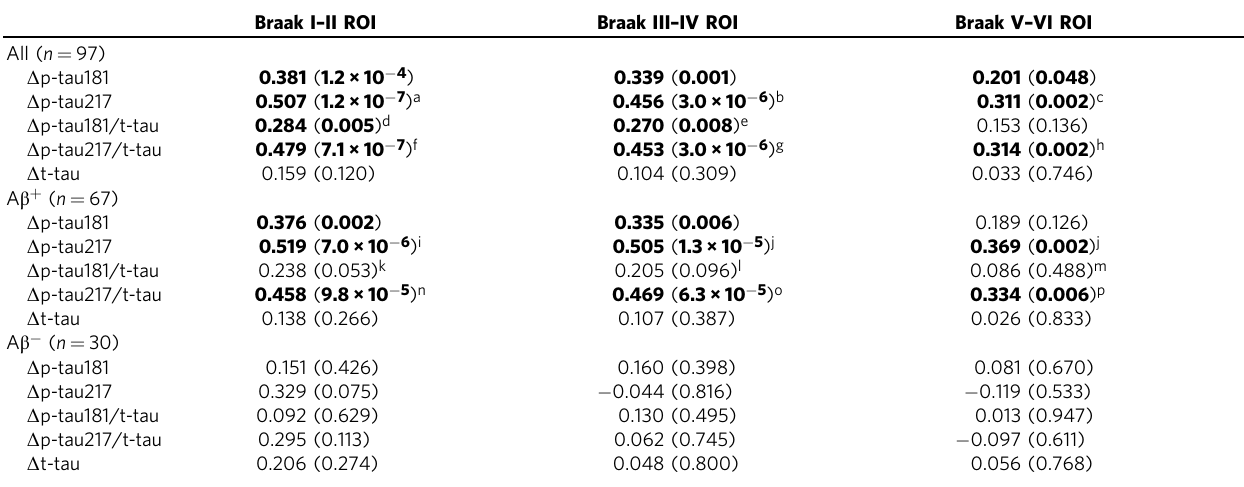
Table 5 Spearman correlations between regional [ 18 F] fl ortaucipir and longitudinal changes in CSF tau